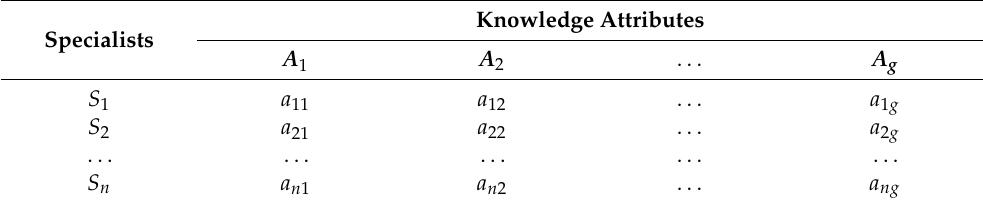
Table 1. Specialist Knowledge Attribute